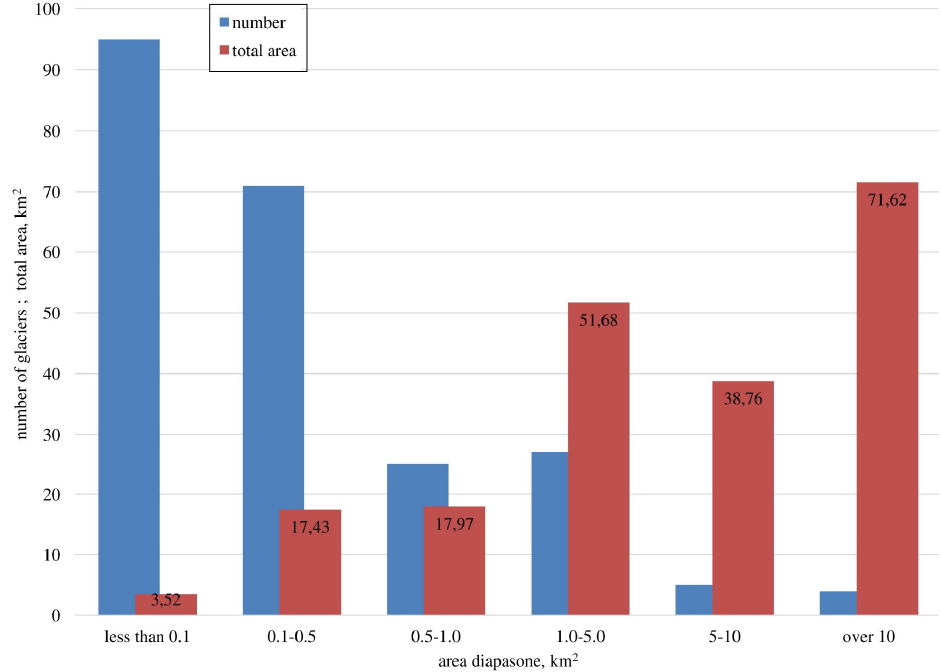
Figure 4. Distribution of the quantity and total area of glaciers in different intervals of areas.